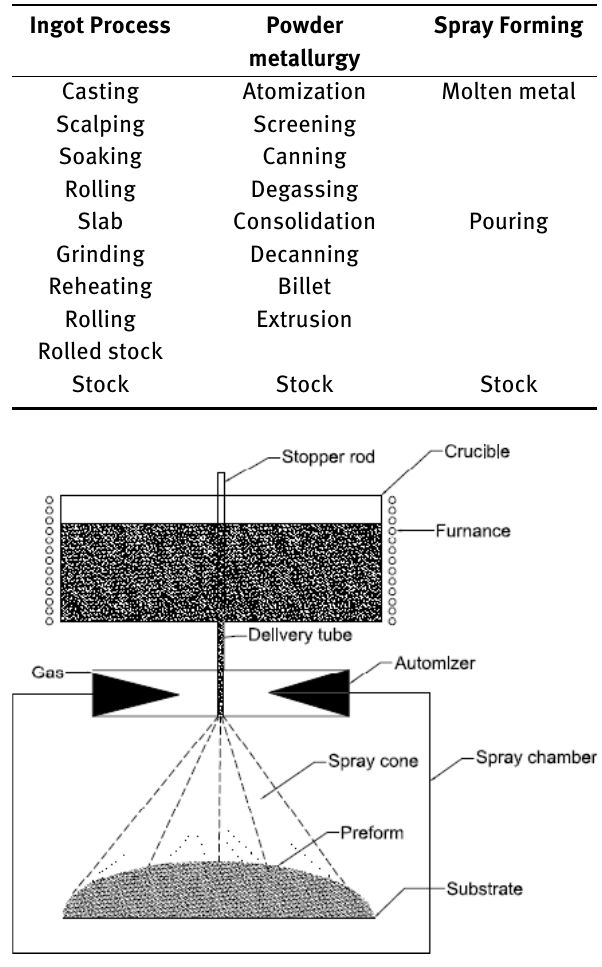
Table 1: Comparison between ingot, powder metallurgy and spray